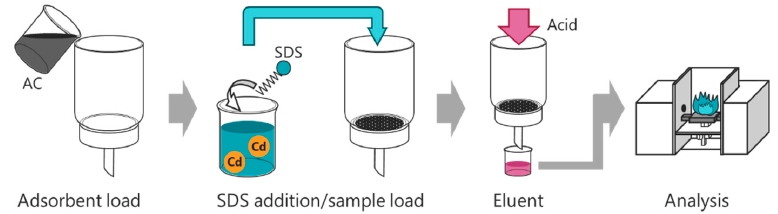
Figure 1. Experimental procedure for the preconcentration of cadmium using sodium dodecyl sulfate/activated carbon (SDS/AC).